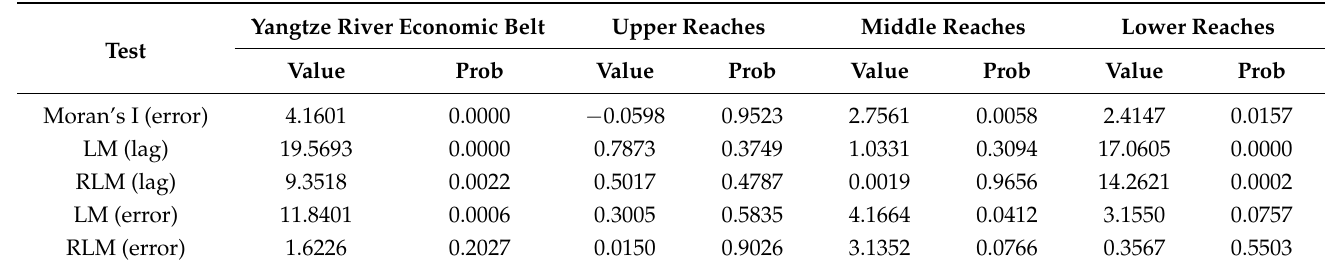
Table 2. Spatial dependence test.